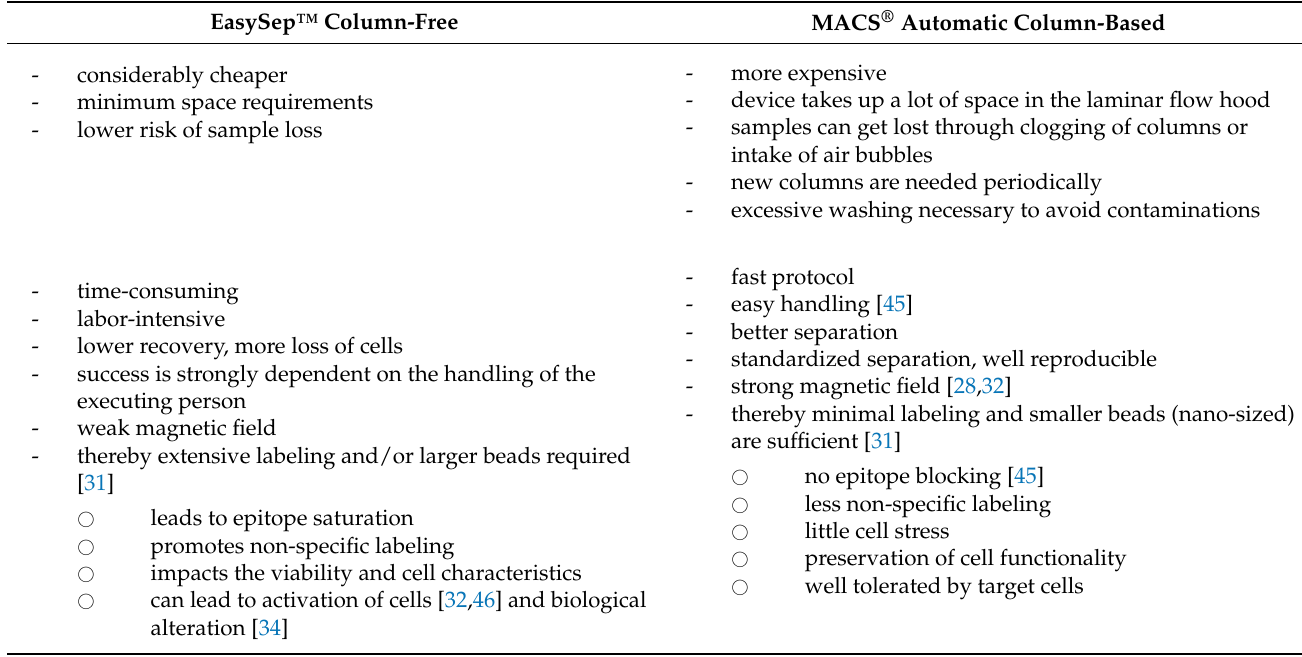
Table 1. Comparison of EasySep™ column-free and MACS ® automatic column-based selection technology.